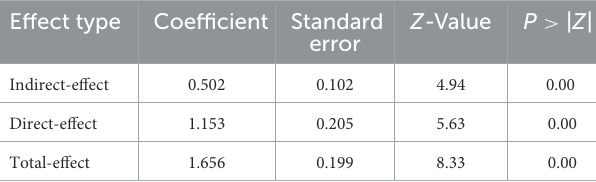
TABLE 5 Decomposition effects and comparison of the KHB method.